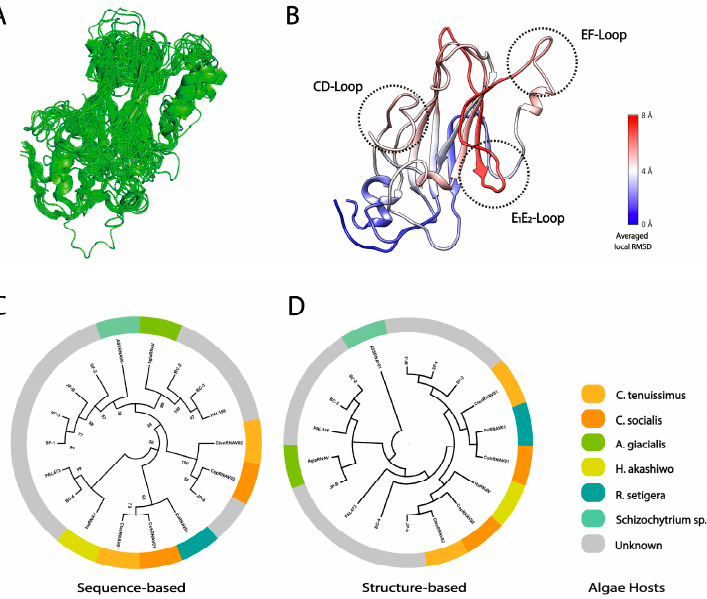
Figure 4. Predicted structural variation in Marnaviridae viruses VP1 and the structure phylogeny. ( A ) Pairwise alignment of 16 predicted structures of Marnaviridae viruses VP1s and two experimental structures of CtenRNAVII and CsfrRNAV VP1s. The N-terminal arms were trimmed for the alignment due to their low accuracy in the predicted structures (Figure S6A); they are not involved in the transmission mechanism. ( B ) Averaged RMSD per residue map of the Marnaviridae virus VP1s calculated against CsfrRNAV VP1. The residues are colored by the attribute of the averaged residue RMSD on the CsfrRNAV VP1 atomic model. ( C ) Amino acid sequence-based phylogeny of the Marnaviridae virus VP1s. ( D ) Structure-based phylogeny generated by the predicted and experimental Marnaviridae virus VP1 structures. ( C , D ) Each clade is colored by identified algae hosts.